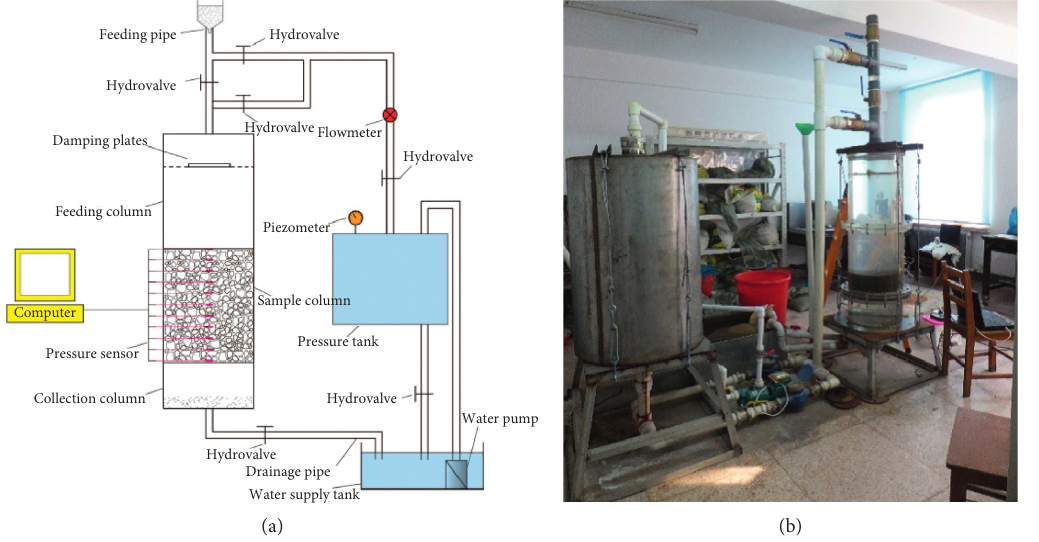
Figure 2: Infiltration-clogging monitor system. (a) Schematic diagram. (b)